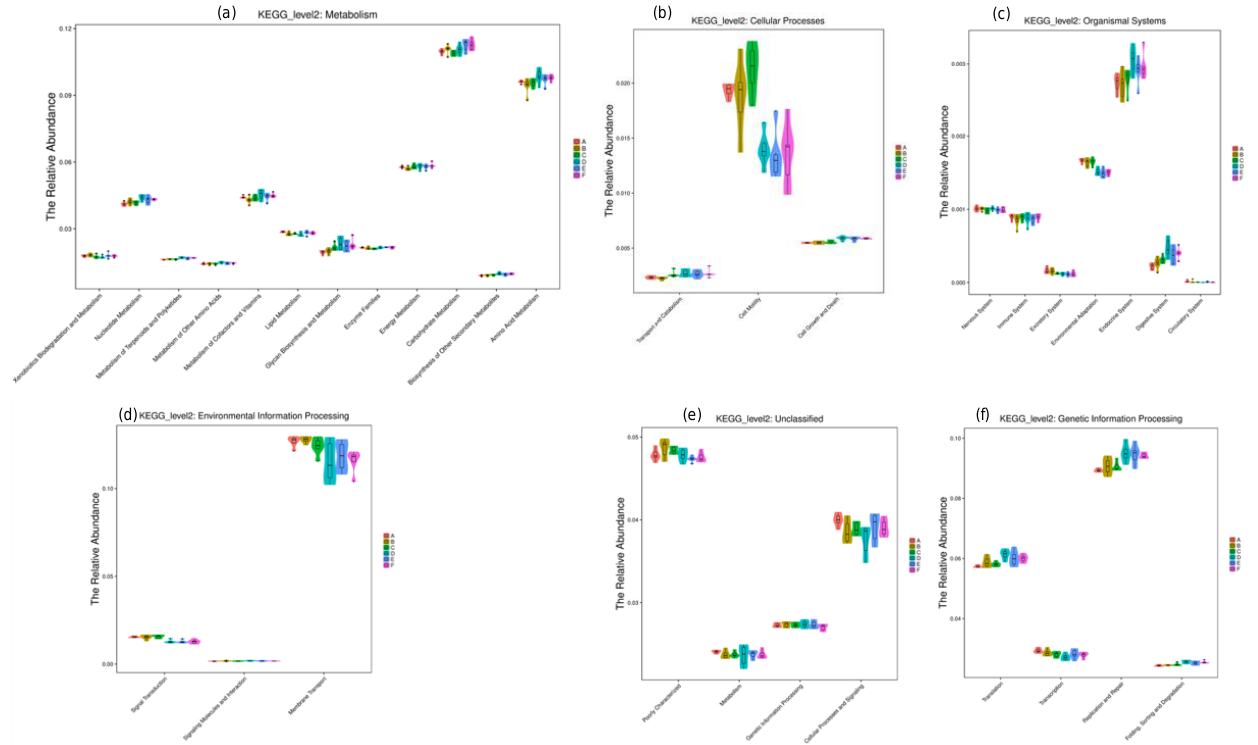
Figure 11. Phylogenetic investigation of communities by reconstruction of unobserved states (PICRUSt) predicted Kyoto encyclopedia of Genes and Genomes (KEGG) at the second level distribution map between the high activities of corn-fed groups and low activity of wheat-fed groups which reflects the number of samples corresponding to the abundance. The predicted KEGG level of ( a ) Metabolism; ( b ) Cellular processes ( c ) Organismal systems ( d ) Environmental information Processing ( e ) Unclassified and ( f ) Genetic information processing are presented for corn-fed and wheat-fed groups.